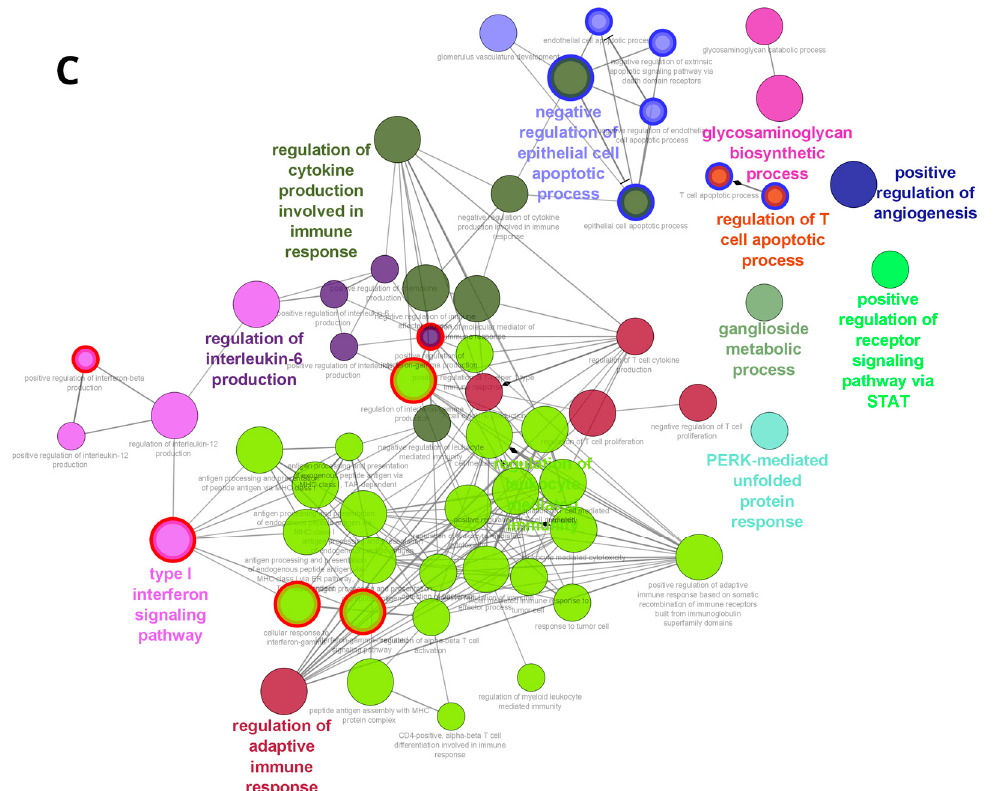
Figure 6. Phylostratigraphic analysis of MDA-MB-231 cells over the time course after DOX treat- ment. ( A ) The phylostratigraphic distributions of differentially expressed (up- and downregulated, abbreviated as “up” and “dn”) genes on days 5, 8, 16, and 22 post-DOX, with the whole-genome phylostratigraphic distribution (red line) serving as the background reference. ( B ) The ClueGO enrichment map representation of GO biological processes enriched (hypergeometric test pAdj < 0.05) in the STRING network of day 5 versus NT upregulated genes corresponding to the eighth phylostratum. The presence of both adaptive and innate immunity modules (including interfer- on-related pathways), angiogenesis, apoptosis, and female pregnancy (blue-framed) is noteworthy. ( C ) ClueGO enrichment map representation of GO biological processes enriched (hypergeometric test pAdj < 0.05) in the STRING network of day 16 versus NT upregulated genes corresponding to the eighth phylostratum. The modules of interferon-related pathways are circled in red; those pertaining to apoptosis are circled in blue. Figure 6B,C can also be viewed interactively in NDEX data base https://www.ndexbio.org/#/networkset/326907d3-a2f3-11ed-9a1f-005056ae23aa?accesskey=d13703 d9d6c991087b20776c62648d36c27d4d92e7c4fea1b7e177a03221963b.